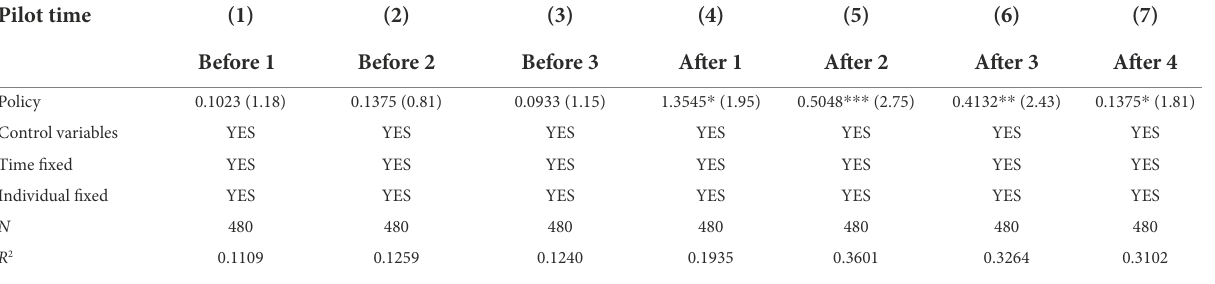
TABLE 4 Regression results of the green total factor productivity parallel trend